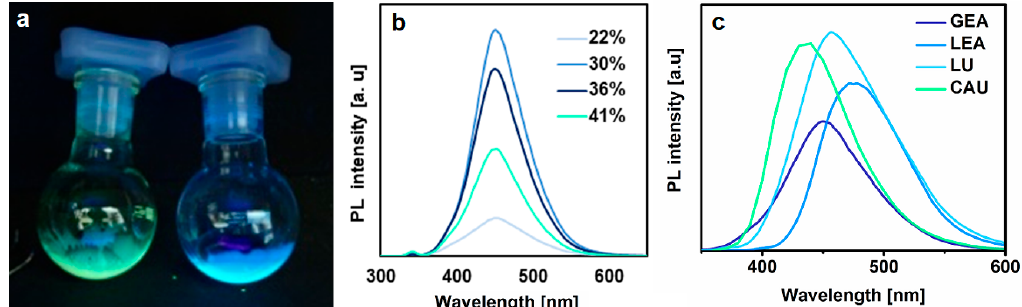
Figure 2. Pictures of aqueous dispersions of LEA ( a , left ) and GEA type CDs ( a , right ) at λ exc = 366 nm. Impact of the EDEA mass fraction (22–41%, v/v) in the precursor mixture (glycerol + EDEA) on PL intensity of GEA-type CDs ( b ). Comparison of PL characteristics of aqueous dispersions (pH 6) of the different types of CDs prepared ( c ).